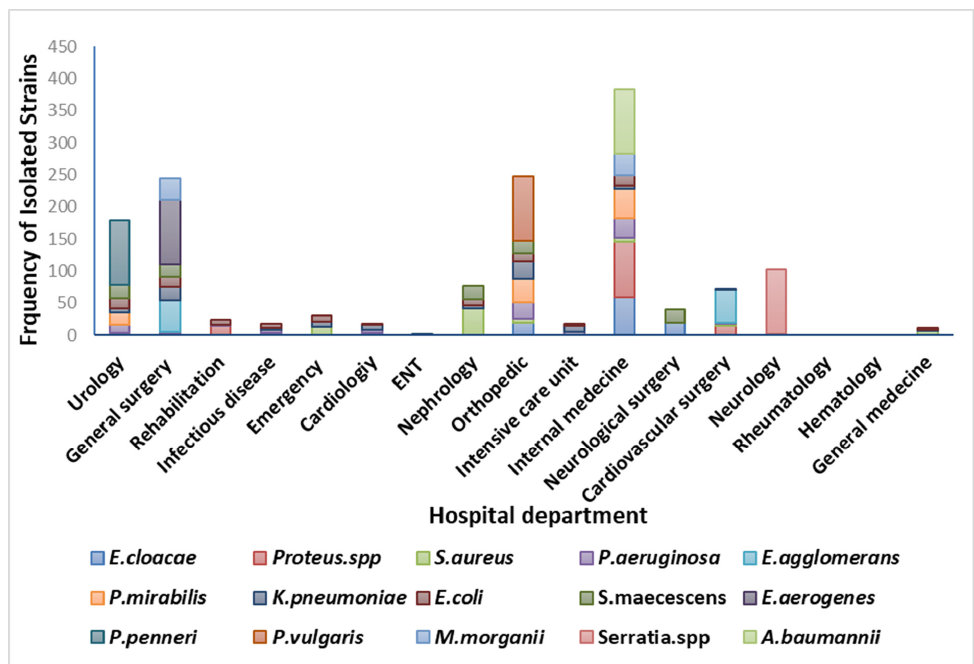
Figure 3. Distribution of isolates according to hospital departments.